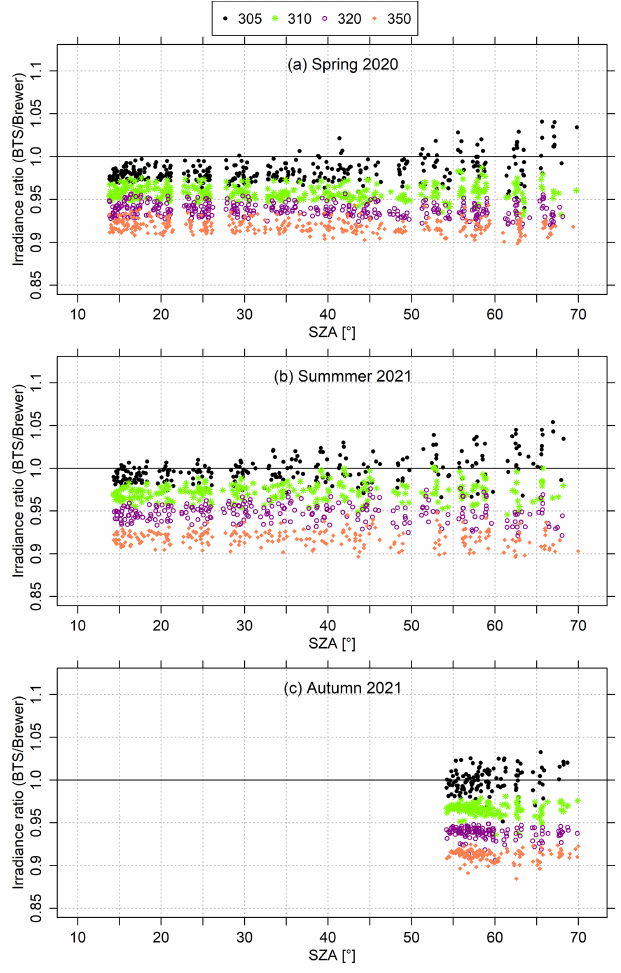
Figure 3. The ratios of global UV spectral irradiance at selected wavelengths between the BTS and the Brewer #150. The measure- ments were obtained from cloud-free conditions and SZAs below 70 ◦ during (a) spring 2020, (b) summer 2021 and (c) autumn 2021. Each data point is calculated from the average over a ± 2 . 5nm wave- length